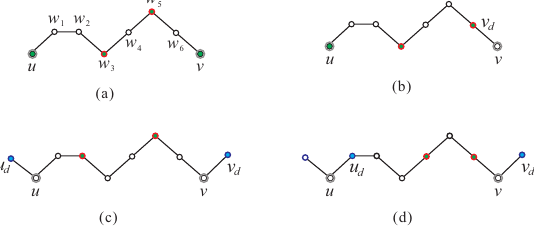
Figure 7. The minimum dominating set of S ( u , v ) in G d for ( a ) u , v ∈ D (cid:48) , ( b ) u ∈ D (cid:48) and v (cid:54)∈ D (cid:48) , ( u ) − S ( u , v )) ∩ D (cid:48) (cid:54) = ∅ and ( N ( v ) − S ( u , v )) ∩ D (cid:48) (cid:54) = ∅ , and ( d ) u , v (cid:54)∈ D (cid:48) ( c ) u , v (cid:54)∈ D (cid:48) and ( N G G d d ( u ) − S ( u , v )) ∩ D (cid:48) = ∅ or ( N ( v ) − S ( u , v )) ∩ D (cid:48) = ∅ , where D (cid:48) is a dominating set of and, ( N G G d d G d and filled circles represent vertices in D (cid:48)